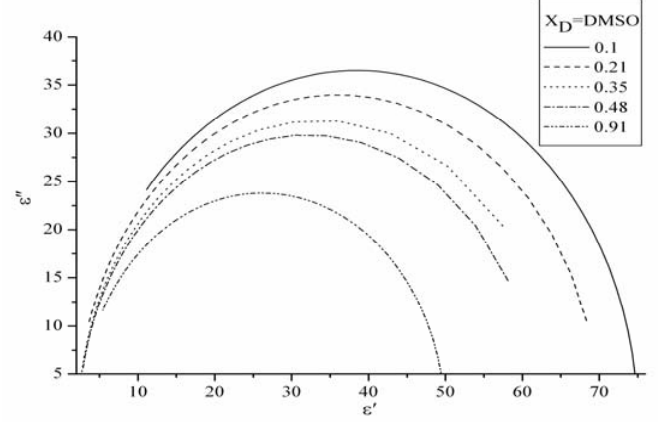
Figure 5. The Cole-Cole curve of DMSO-water mixture at various